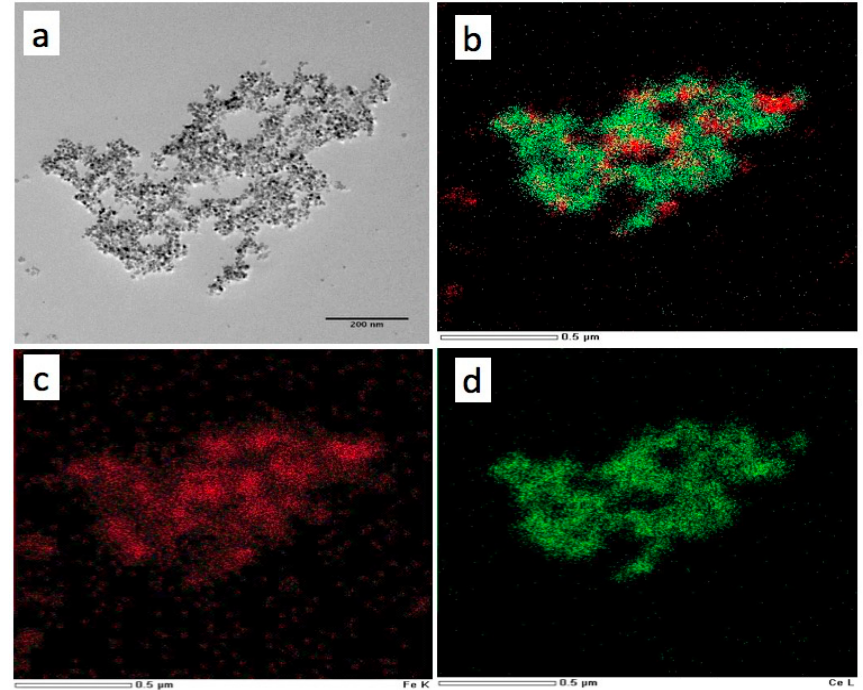
Figure 3. ( a ) TEM image of an aggregate of Fe 2 O 3 and CeO 2 NPs; ( b ) Electron energy loss spectroscopy (EELS) analysis of Fe (red) and Ce (green) in the aggregates; ( c ) separated EELS map of the Fe (red) content; ( d ) separated EELS map of the Ce (green) content.